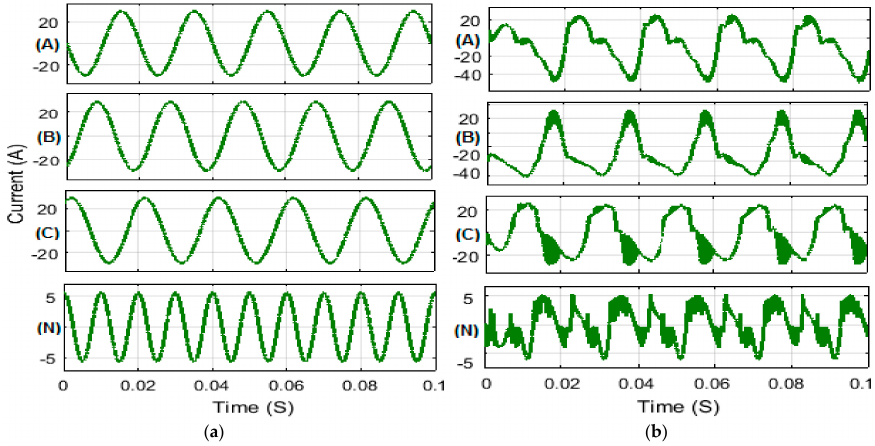
Figure 12. Inverter output current with split inductor for different load by effectual 3D-SVM scheme ( a ) 4-leg inverter current under balanced load; and ( b ) 4-leg inverter current under unbalanced